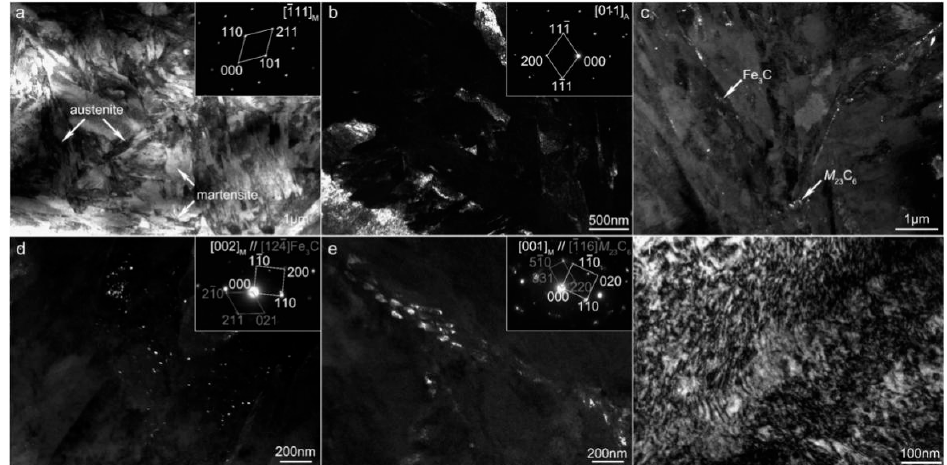
Figure 4. TEM analysis of the as-cladded specimens: ( a ) BF image; ( b ) DF image and SAED pattern of austenite; ( c ) DF image of carbides; ( d ) DF image and the SAED pattern of Fe 3 C; ( e ) DF image and the SAED pattern of M 23 C 6 ; ( f ) dislocation.